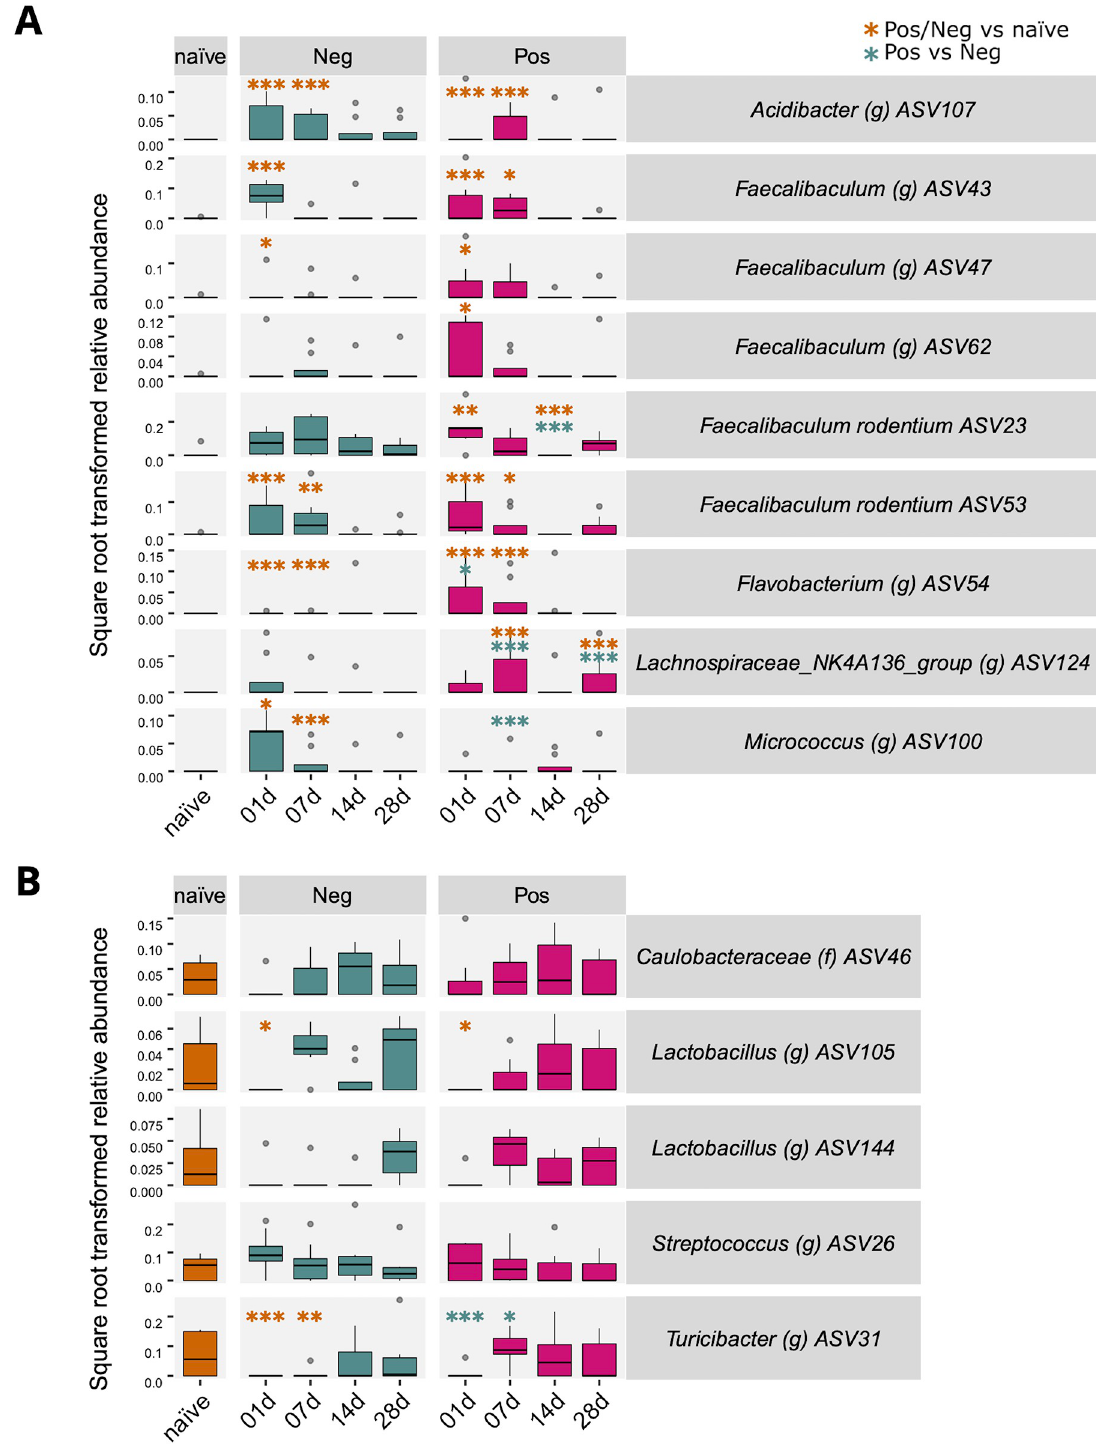
PLOS ONE | https://doi.org/10.1371/journal.pone.0276071 October 20,